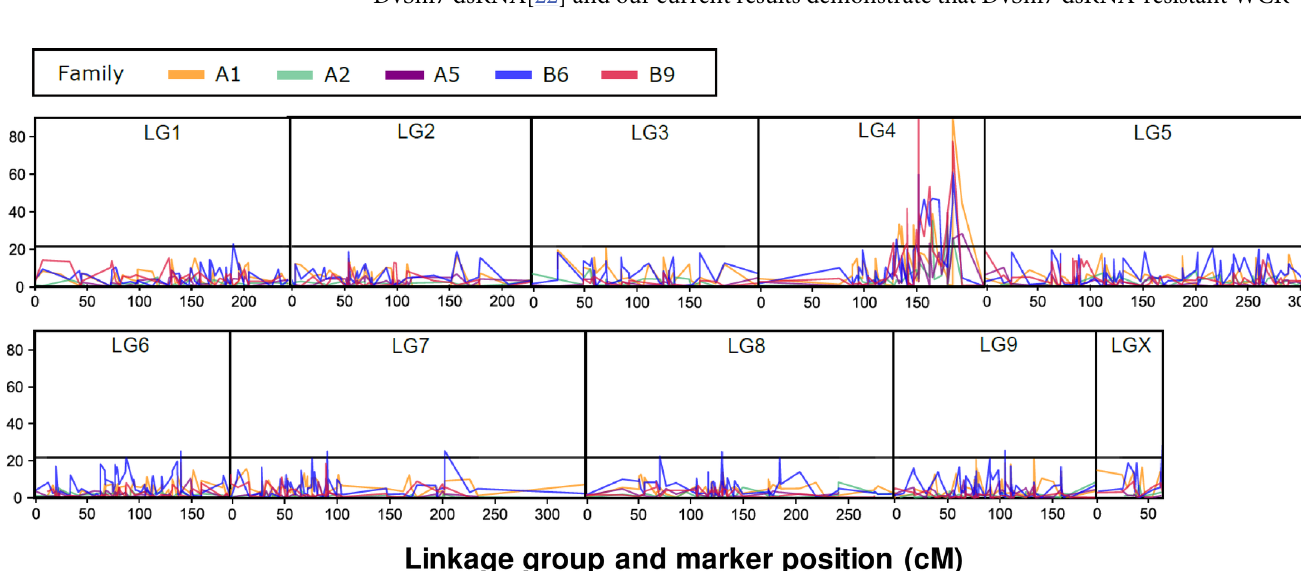
PLOS ONE | https://doi.org/10.1371/journal.pone.0197059 May 14,